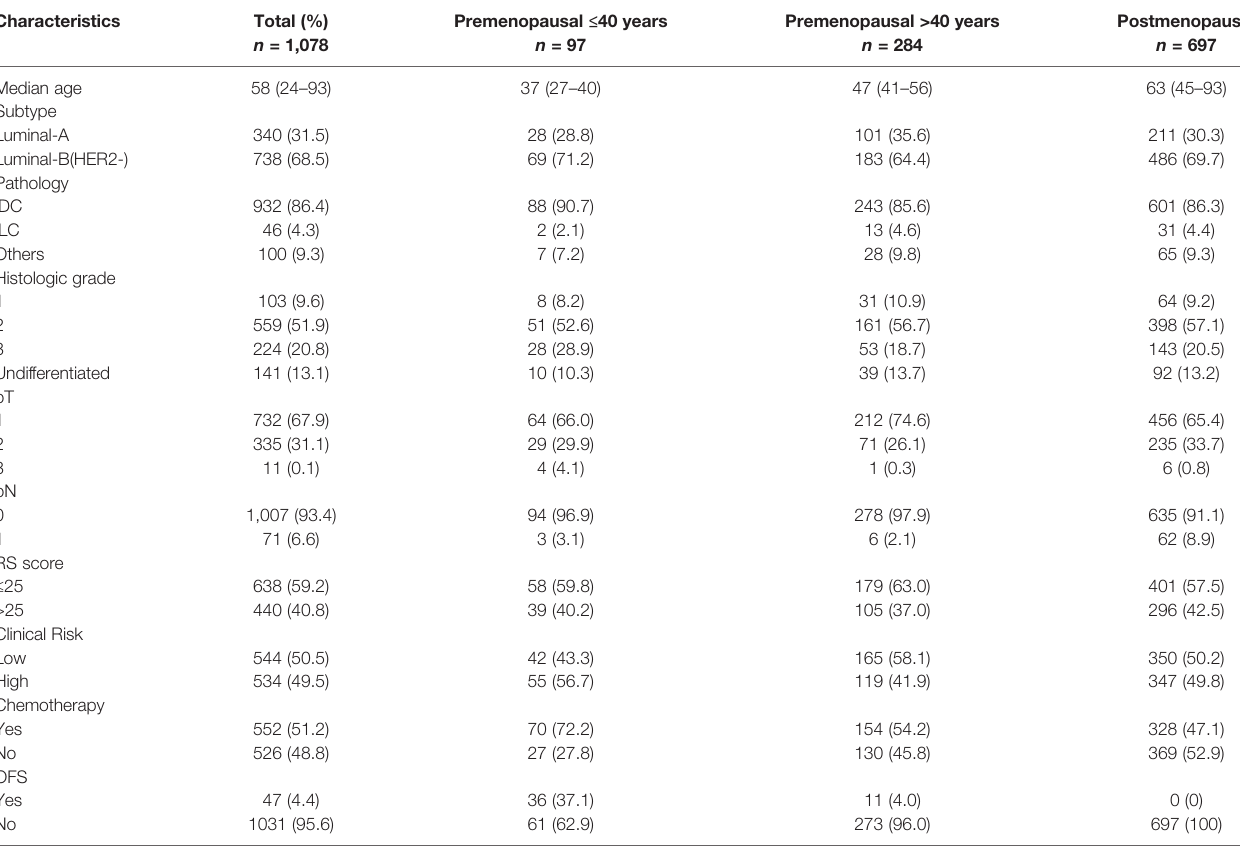
TABLE 1 | Basic features of HR+/HER2- early breast cancer patients from SJTU-BCDC.